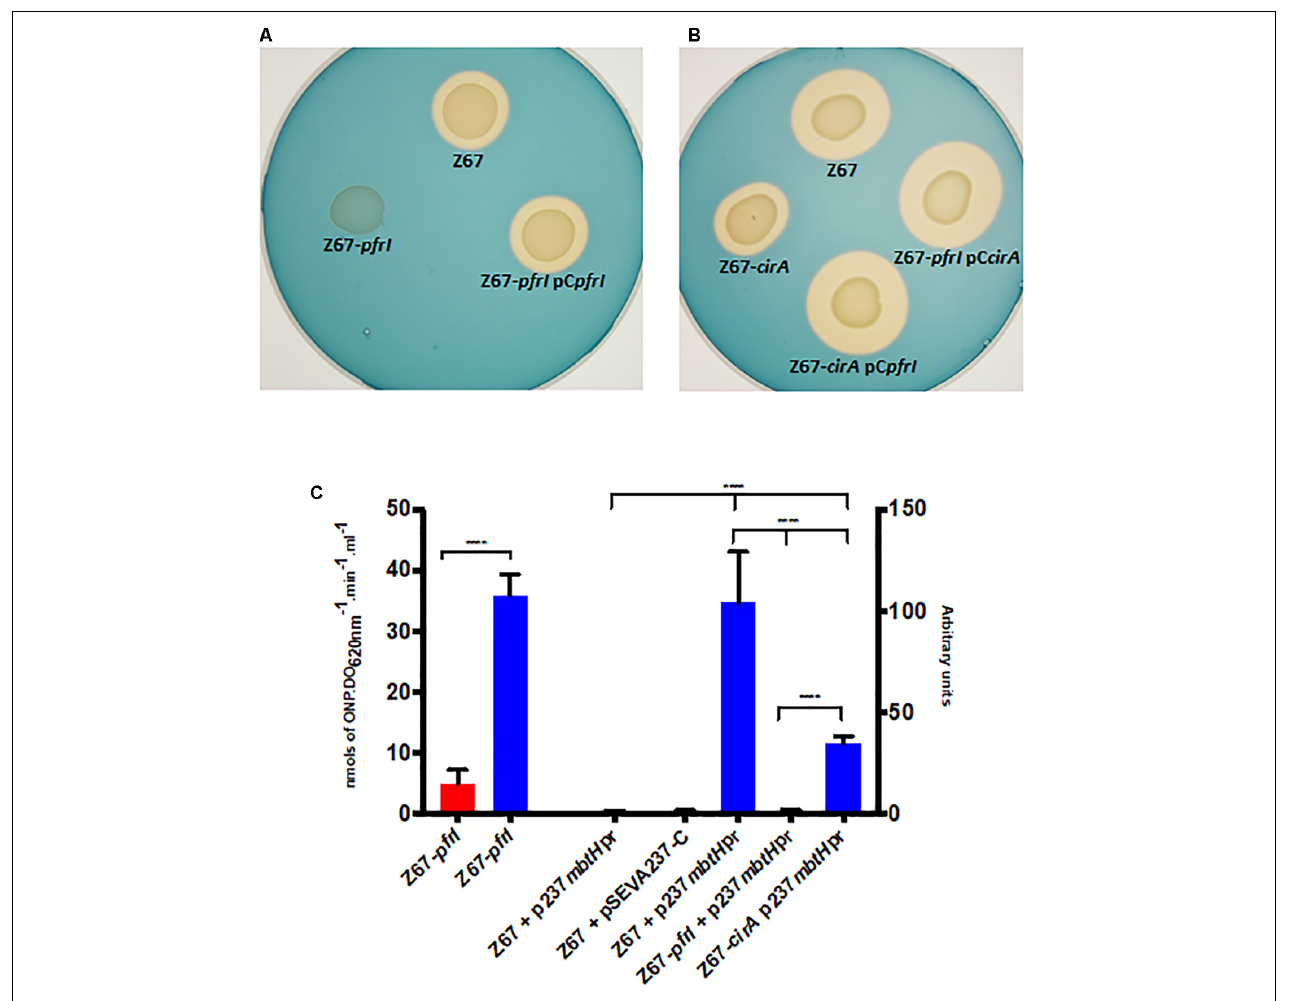
FIGURE 4 | Phenotypic characterization of mutant strains Z67- pfrI and Z67- cirA . Serobactins production/internalization of H. seropedicae Z67 wild-type strain, Z67- pfrI (A) and Z67- cirA (B) mutant strains on solid CAS medium with or without complementing plasmids as indicated. Ten microliters of a late exponential phase culture containing 1 × 10 6 CFU were spotted onto the CAS solid medium and incubated for 24 h (A) or 48 h (B) at 30 ◦ C. (C) Left: β -galactosidase activity of the Z67- pfrI mutant strain growing in NfbHP-malate with 37 µ M FeCl 3 (red bar) or with 50 µ M DP (blue bar). Right: CFP expression of different strains containing the plasmid p237 mbtH pr or the empty vector pSEVA237-C. The expression of all strains in NfbHP-malate with 37 µ M FeCl 3 presented similar values close to 1 and similar to the wild type strain with the empty vector in the same condition. Only the wild type is represented (Z67 p237 mbtH pr, third bar). Z67 pSEVA237-C bar correspond to the expression of this strain in NfbHP-malate with 50 µ M DP. The remaining three bars correspond to the expression of CFP in the indicated strain in NfbHP-malate with 50 µ M DP. Results are the average of at least three independent experiments with four or more technical replicates each. Bars represent the 95% CI of the mean. Statistical analysis was performed using ordinary One-way ANOVA without correction for multiple comparisons. ∗∗∗∗ p <